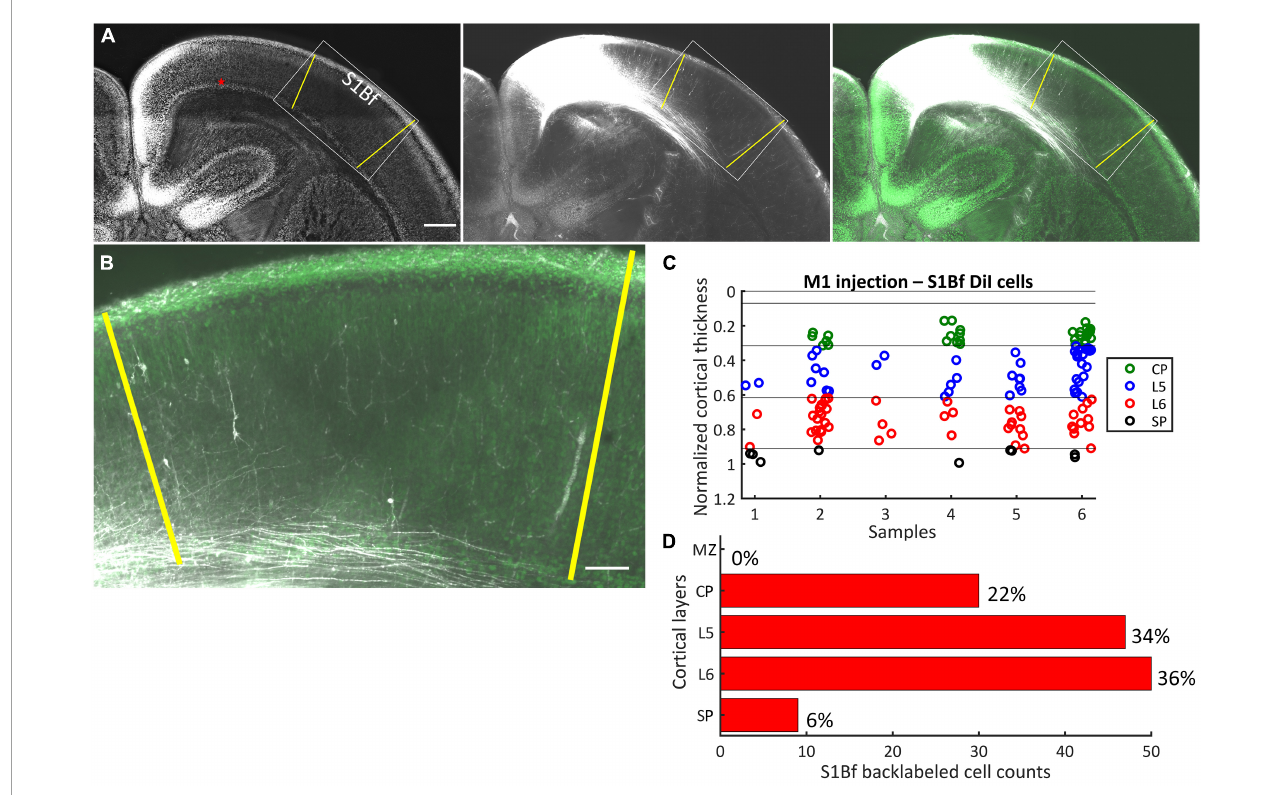
FIGURE2 DiI labeling pattern and localization of DiI backlabeled cells in S1Bf on six M1 injected samples. (A) Representative photomicrograph showing the DiI labeling pattern in S1Bf on M1 injected sample. Image was prepared as a maximum intensity projection of selected stacks of 350 µ m thick sample. Left panel: NeuN counterstain of DiI injected sample. Red asterisk indicates the DiI injection site in M1. Yellow lines demark S1Bf from the adjacent primary somatosensory cortices, according to reference points in the developing mouse brain atlas (Paxinos, 2007). Middle panel: DiI tracer spreading pattern toward S1Bf. Right panel: Composite image of the DiI signal and the NeuN signal showing the DiI spread toward S1Bf. (B) Representative S1Bf area, as indicated in the rectangle on panel (A) , showing backlabeled cell distribution across cortical layers. Scale bars are 500 µ m (A) and 100 µ m (B) . (C) Scatter plot showing the localization of manually detected somata of backlabeled cells through the normalized cortical thickness in six S1Bf injected samples. Zero level at the y axis refers to the pial surface, level 1 indicates the SP-white matter boundary. (D) Quantification of observed counts of backlabeled cells in